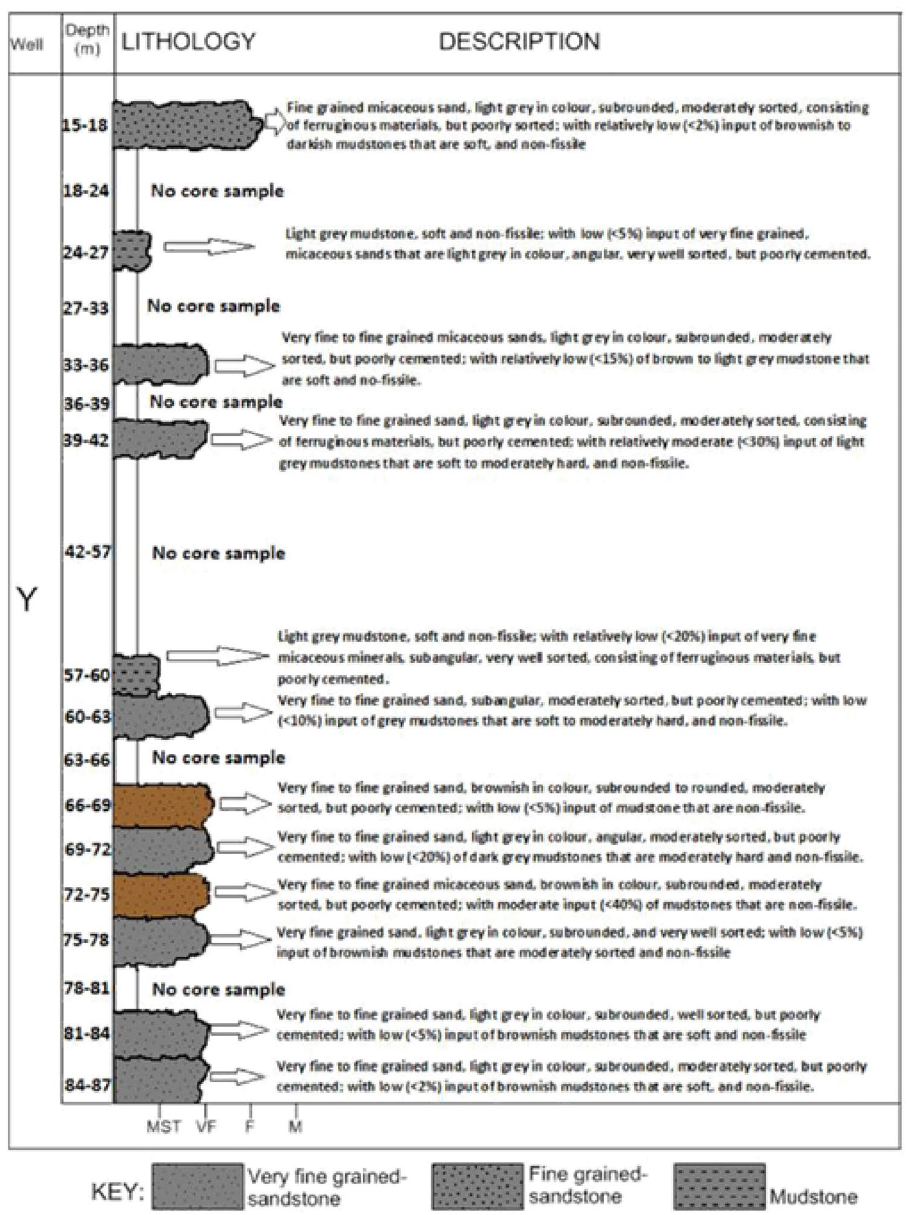
Fig. 4 Litho-section of core samples at Araromi-Obu/Ago- Alaye (Well